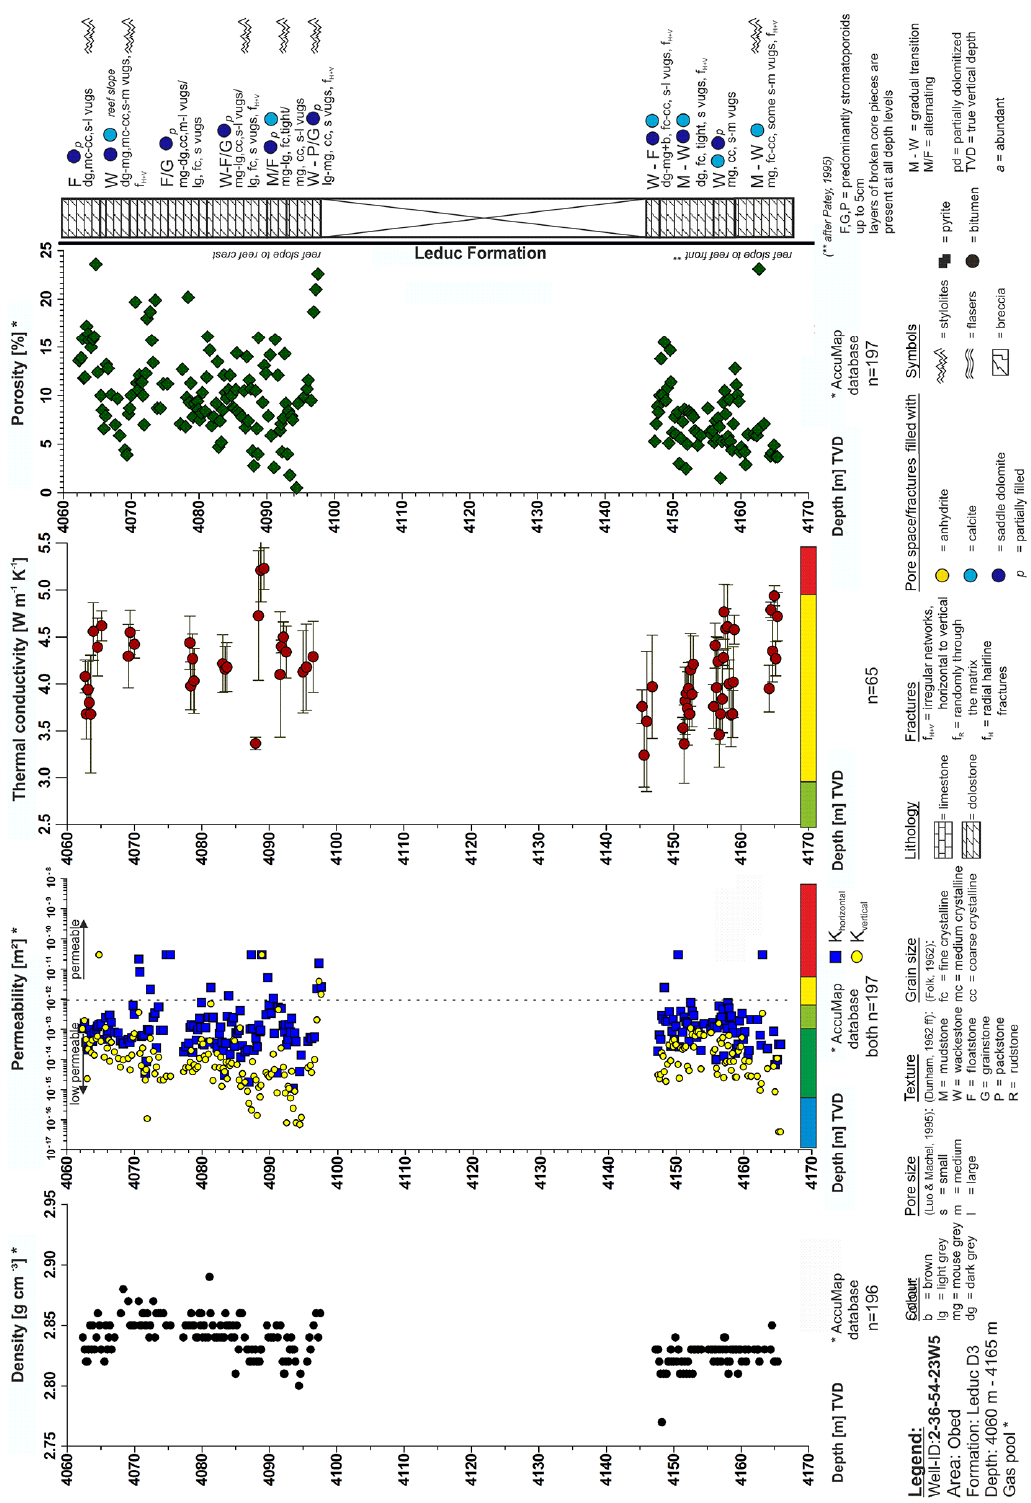
Figure 10. Rock properties of well 2-36-54-23W5 (Leduc Formation, SCCC). Thermal conductivity is displayed as arithmetic mean values with standard deviation. Density, permeability, and porosity were retrieved from the AccuMap database. Apparent permeability is not dis- played here, but lies in the range of the permeability values taken from the AccuMap database. N represents the number of analyzed core